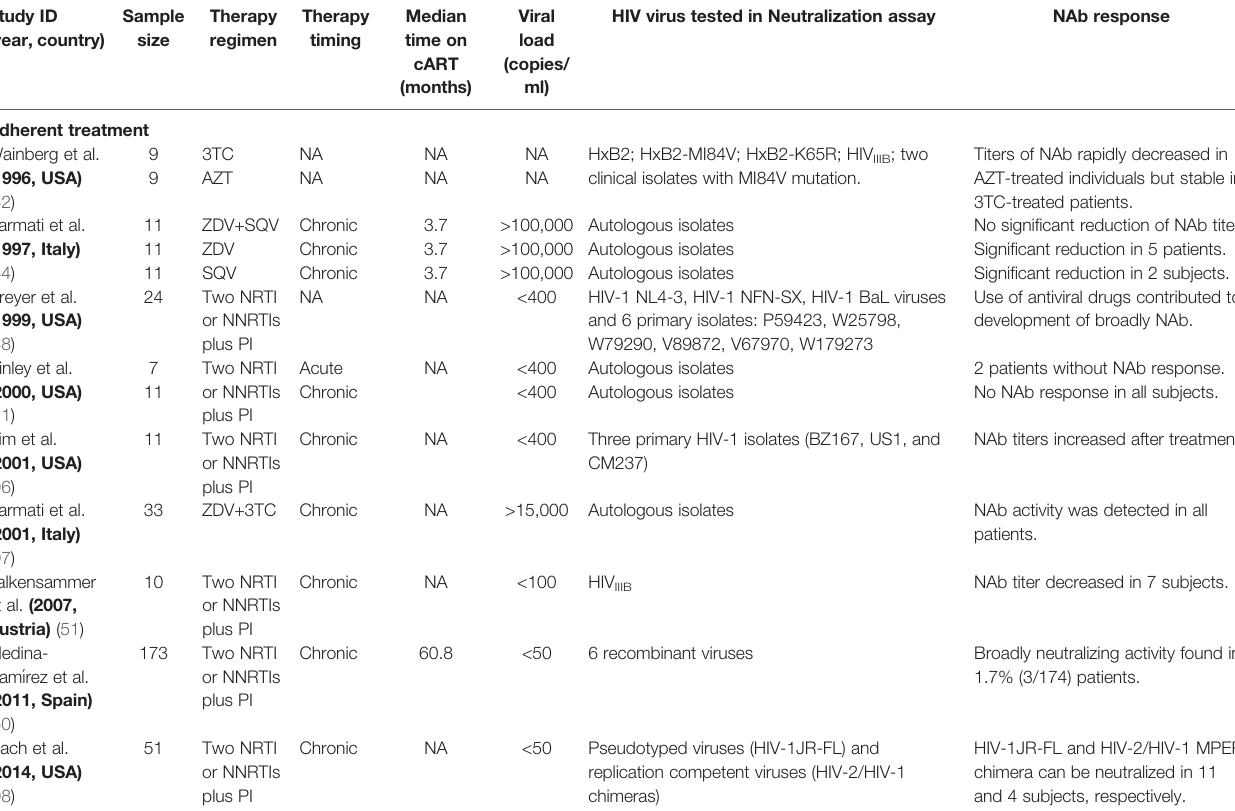
TABLE 8 | Effect of antiviral therapy on HIV-1-speci fi c neutralizing antibodies (NAb) in adult patients. Study ID Sample Therapy Therapy (year, country) size regimen